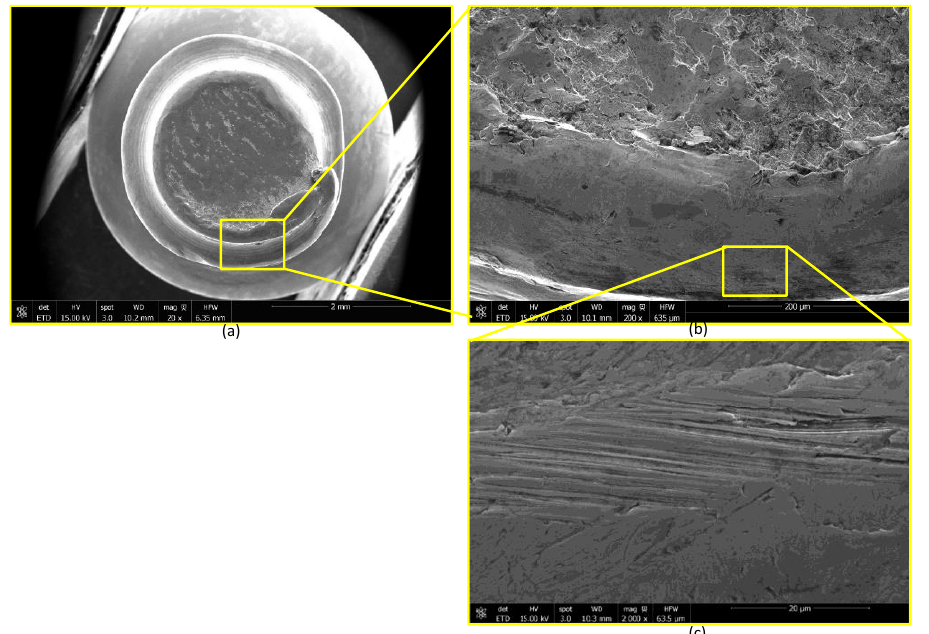
Figure A7. ( a ) Montage of SEM images showing fracture surface of the cortical screw (CS1), ( b – d ) striations, river lines perpendicular to striations. River lines point towards the initiation point (river lines run bottom left to top right).